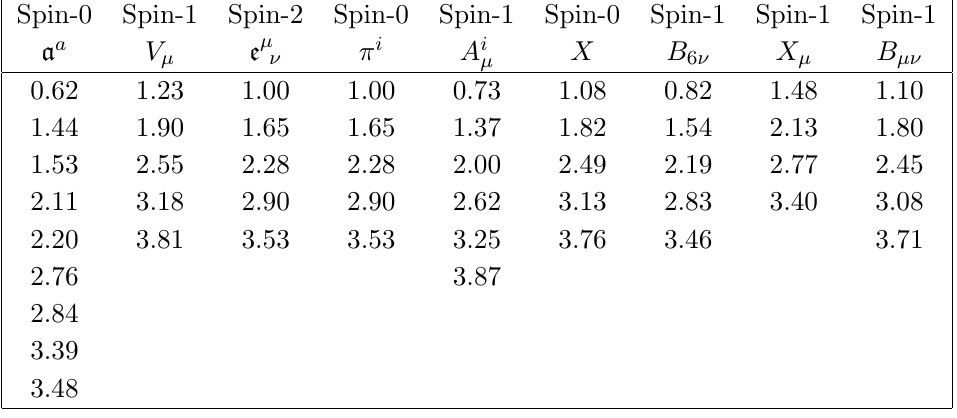
Table 2 . Same as table 1, but with (cid:30) = (cid:30)